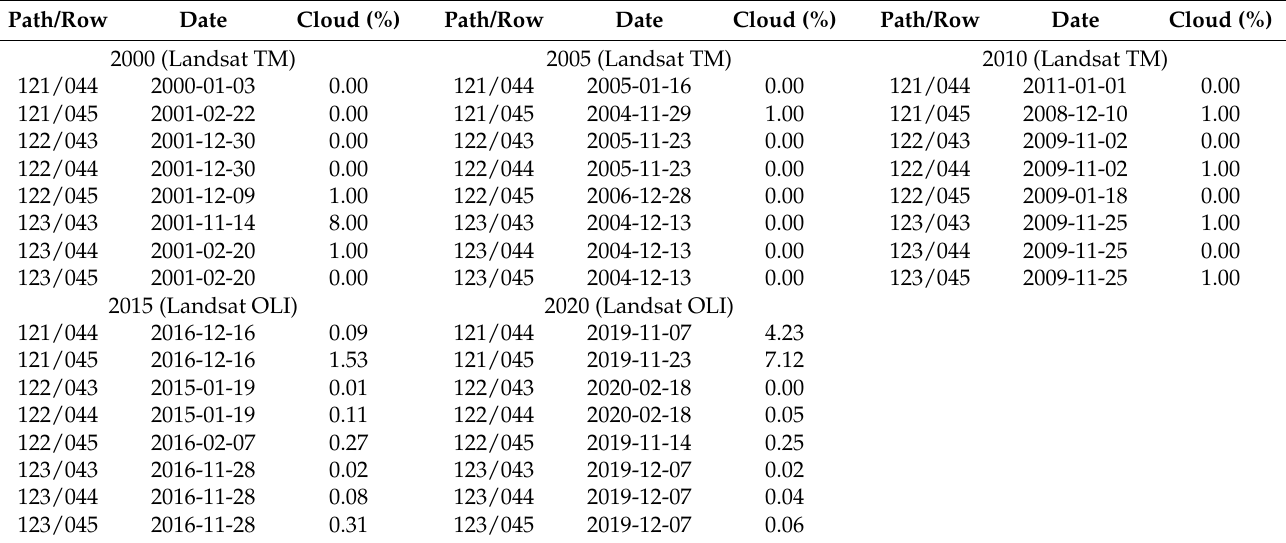
Table 3. Information of Landsat images used in this